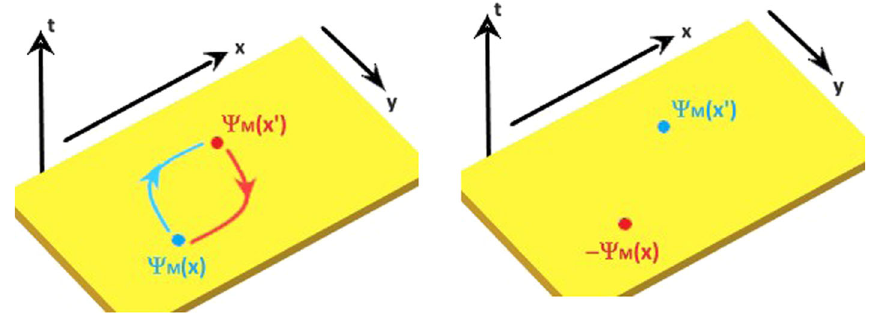
Fig. 3 Left panel shows that the two Majorana fermions (cid:3)( x ) and (cid:3)( x (cid:13) ) confined in two spatial dimensions at positions x and x (cid:13) , denoted by blue and red dots, respectively. The arrows indicated how they are exchanged (half-braided) with each other. Right panel shows that, after